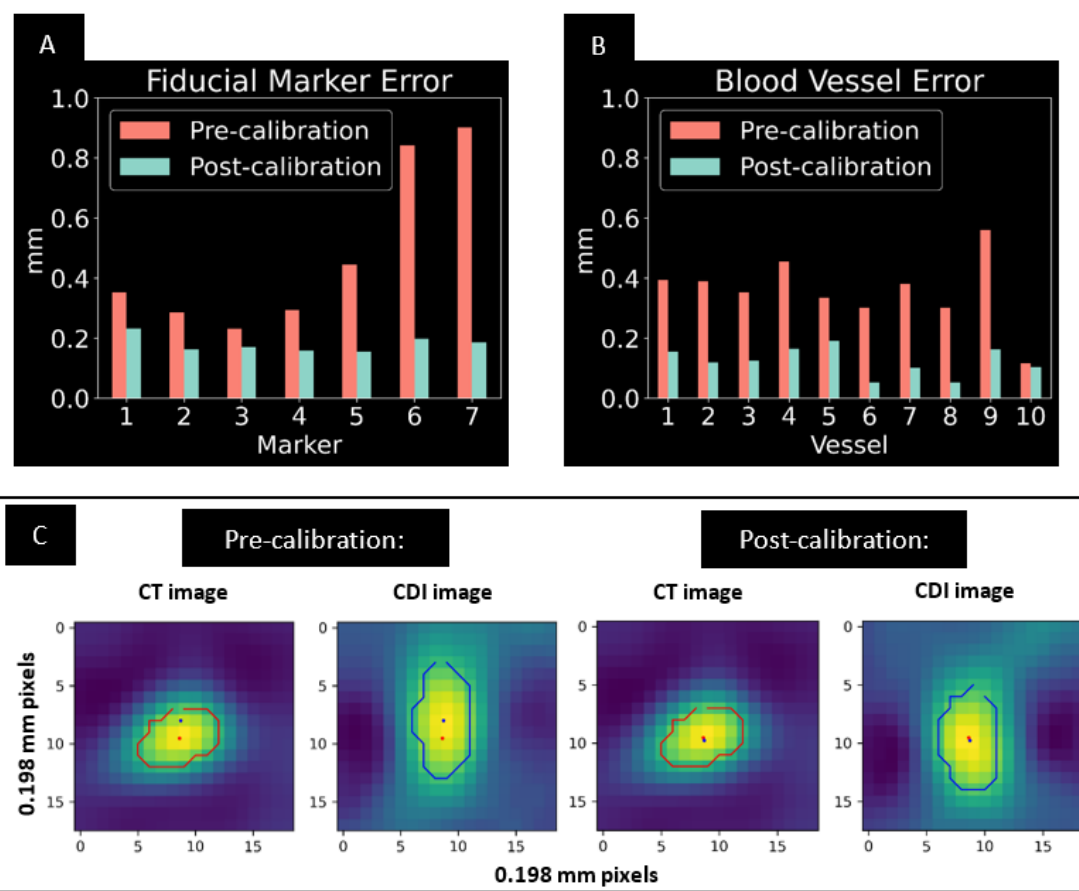
Figure 3. ( A ) Pre- and post-calibration 3D alignment errors of the marker beads between the CDI images and the CT images. ( B ) Pre- and post-calibration 2D alignment errors of small blood vessels (< 2 mm diameter) between the two detectors in the axial plane. The vessels were distributed evenly in the reconstructed volume. ( C ) An example of a blood vessel position in the CT images (red contour) and CDI images (blue contour). The red and blue dots are the center-of-mass positions of the vessel in the CDI and CT images, respectively.